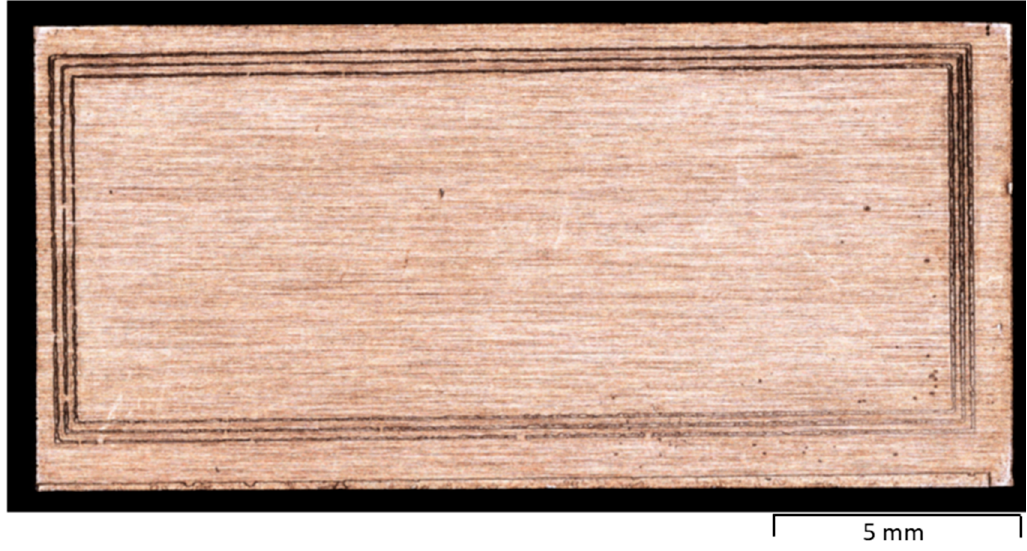
Figure 12. Oxygen-free copper substrate for thermal spreading in the package of hollowed GaN chips after micro-embossing.